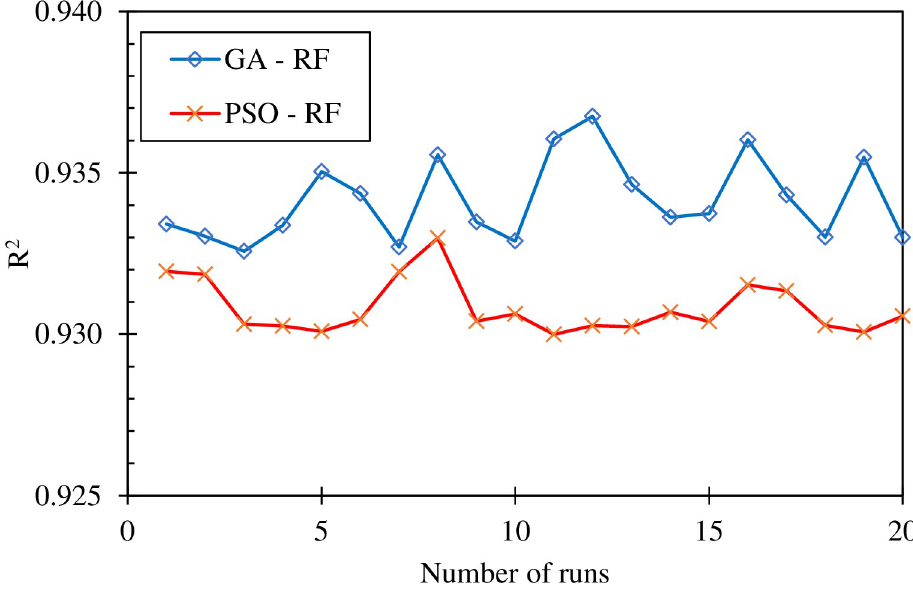
Fig 8. Best value of R 2 in 20 optimization runs using RF-GA and